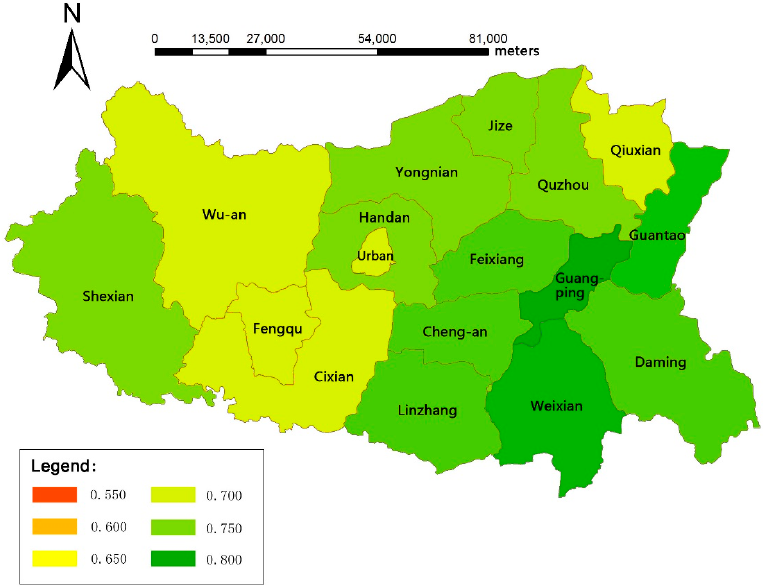
Figure 7. Spatial distribution of SWA in the normal hydrological year (2010).